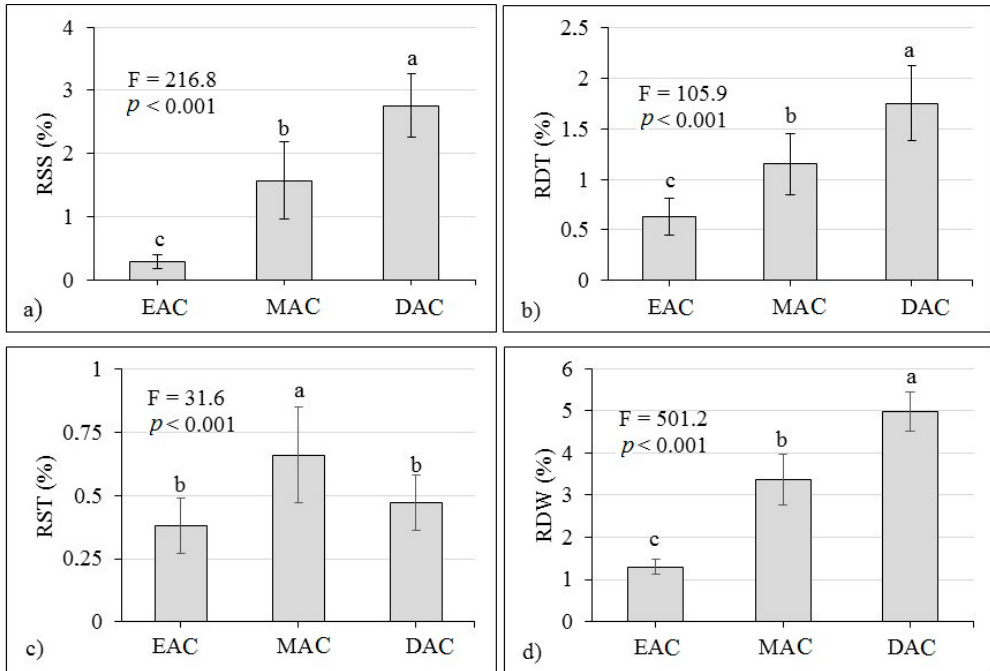
Figure 2. ( a ) Values of RSS (Snag/Standing volume), ( b ) RDT (Downed logs/Trees), ( c ) RST (Stump/Trees) and ( d ) RDW (CWD/standing volume) in the human accessibility classes: EAC = easy accessibility class, MAC = medium accessibility class, and DAC = difficult accessibility class.